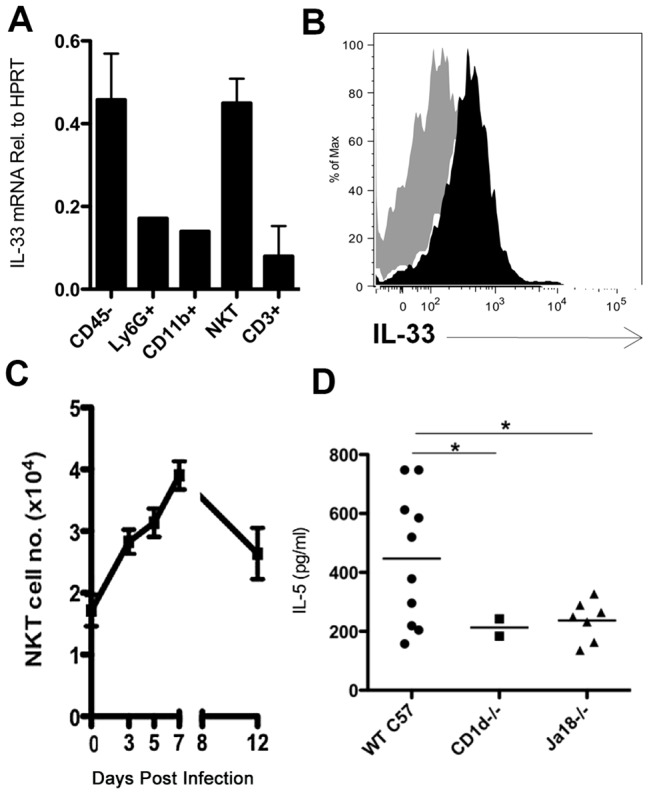
NKT are an in vivo source of IL-33.(A) IL-33 mRNA found in cell populations FACS sorted from the lung at 12 d.p.i.. (B) IL-33 protein in NKT as detected by intracellular staining (filled) compared to FMO control (shaded gray) at 12 d.p.i. (C) Total NKT cells identified in the influenza-infected lung as defined by CD3 and CD1d tetramer staining. (D) BAL IL-5 levels at 7 d.p.i. in indicated mouse strains. Data is representative of at least 2 independent experiments with 2–3 mice each. mRNA was collected from pooled, sorted cell populations from >5 mice. Bars = +/− SEM. *p<.05.